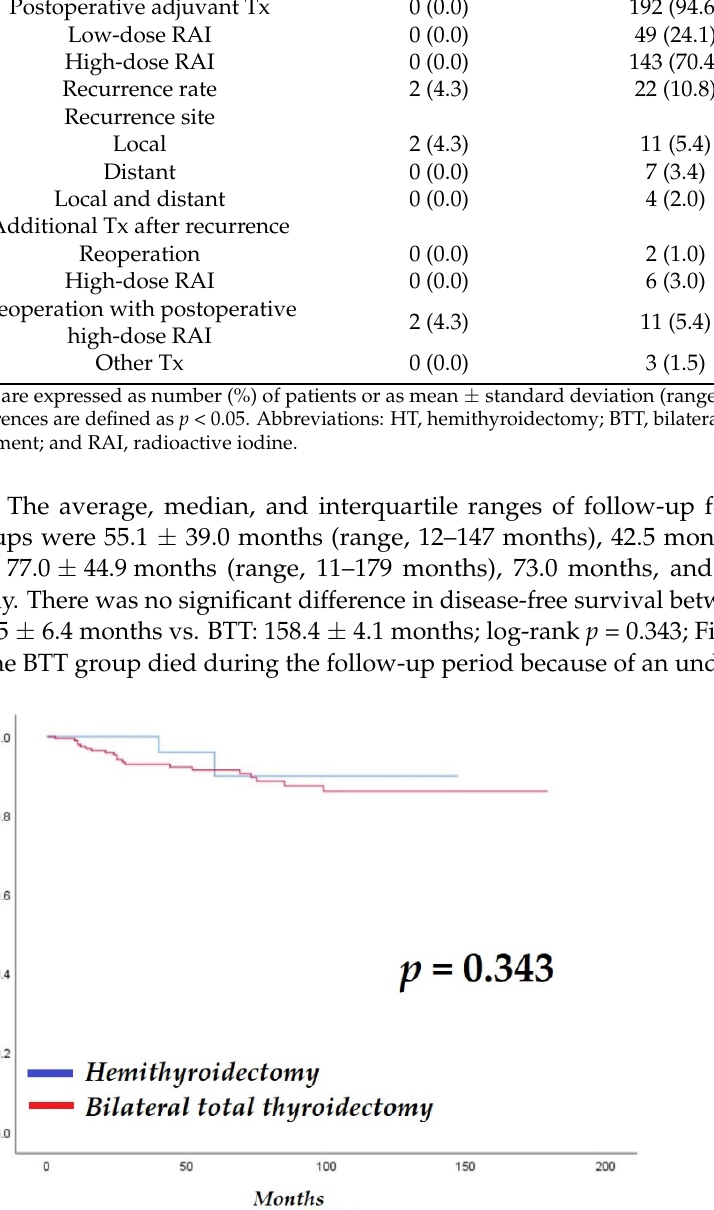
Figure 1. Comparison of disease-free survival between patients with aggressive variants of papillary thyroid cancer who underwent hemithyroidectomy or bilateral total thyroidectomy.